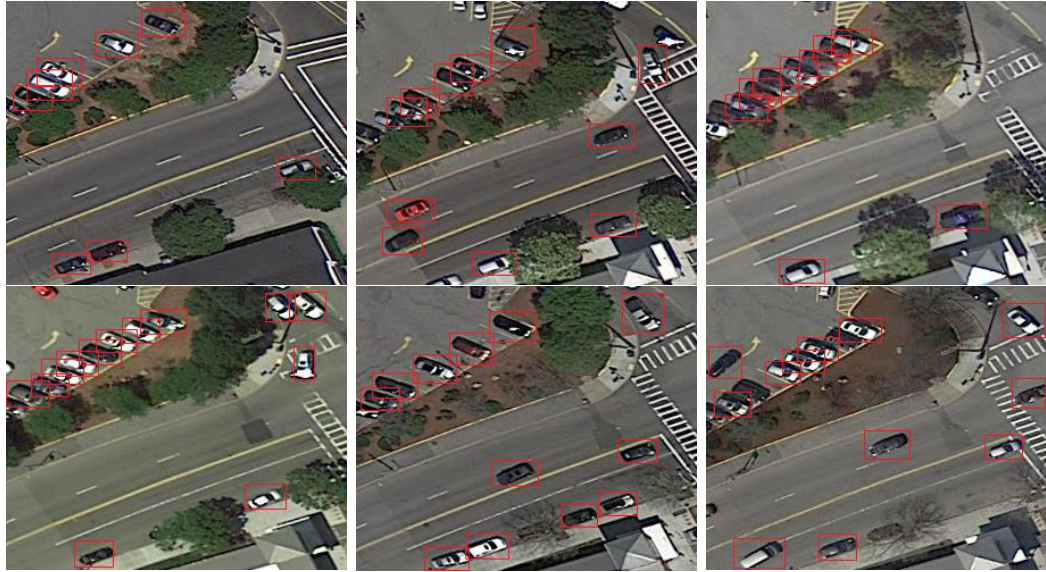
Figure 18. The detection results in same area at different times.